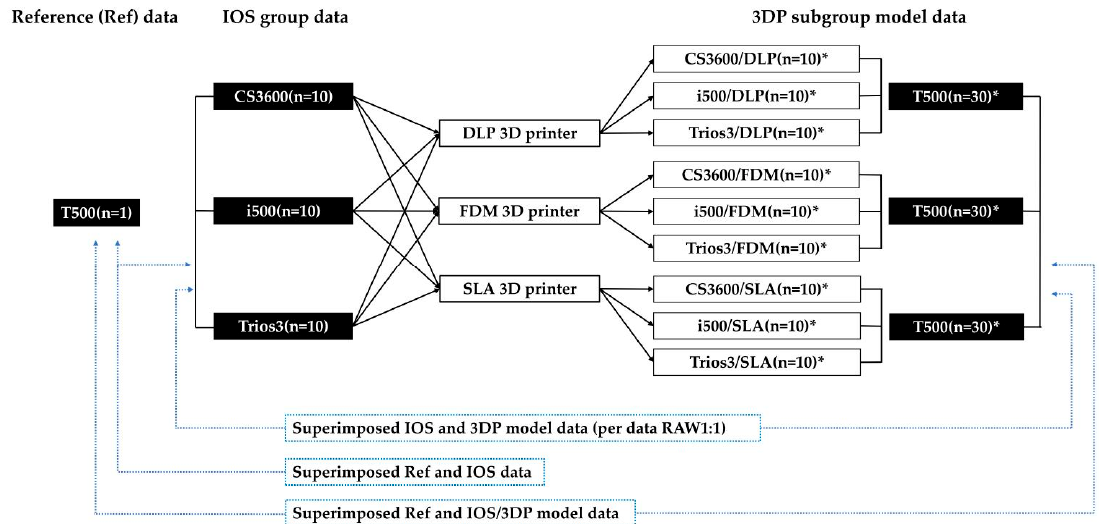
Figure 2. Three main groups (Ref-IOS, Ref-IOS/3D printed models (3DP), and IOS-3DP data) of the superimposed data read workflow diagram. (* Each printed model was scanned with a tabletop scanner to obtain standard tessellation language (STL) data).